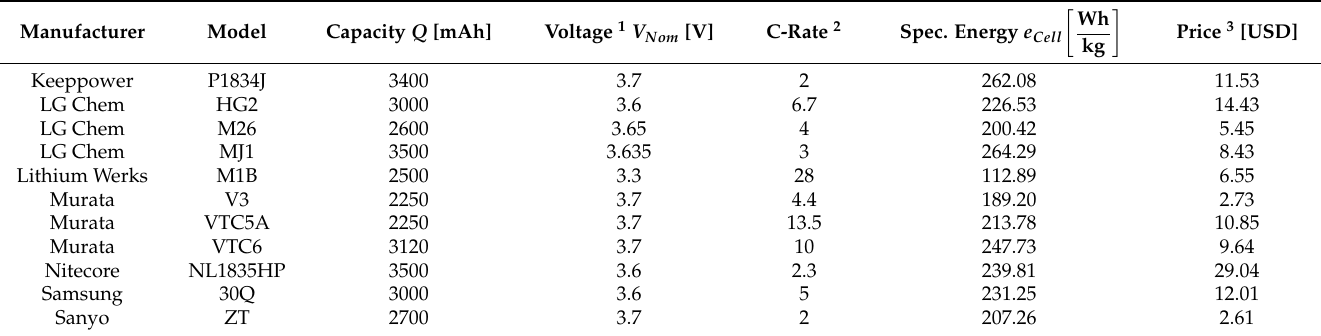
Table 1. Nominal parameters of the examined battery cells.